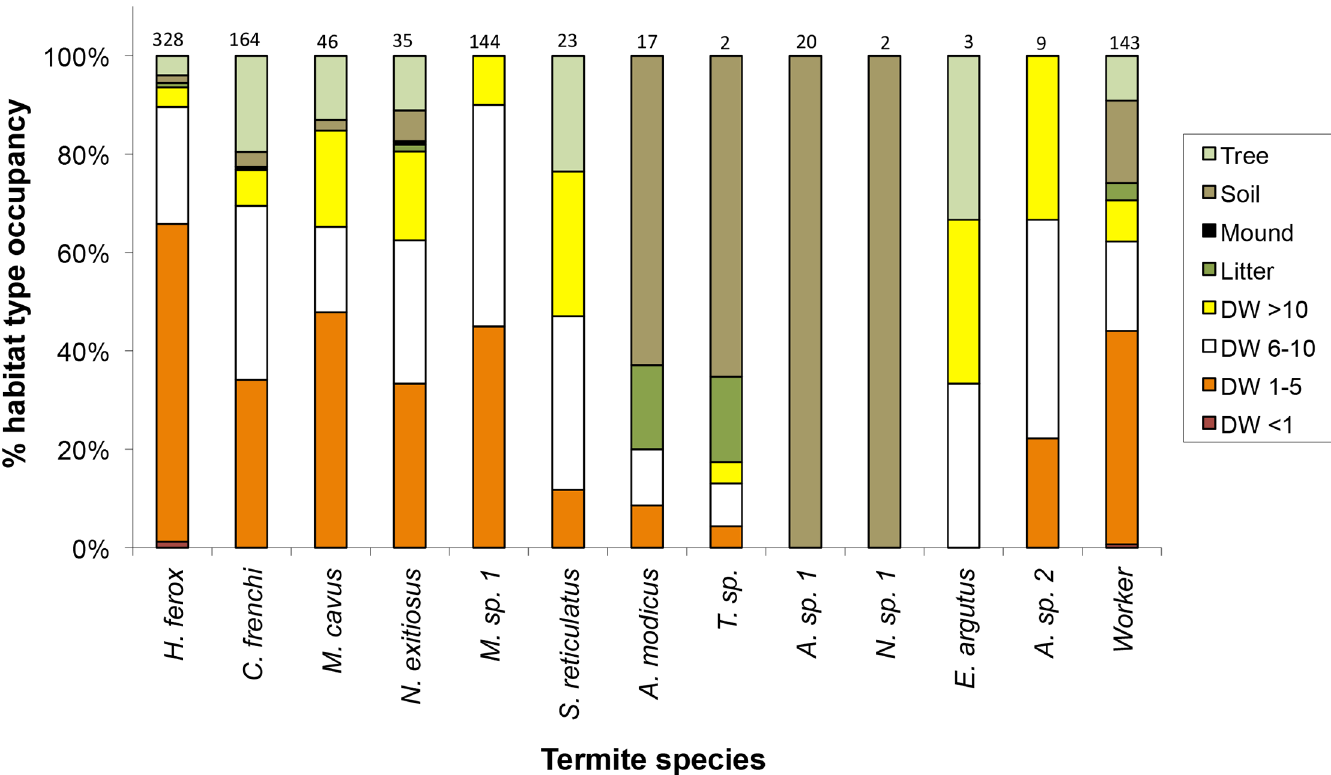
Fig 1. Habitat components in which each termite species was found. Shown as the percentage of records (total records at top of bars). DW < 1 = dead wood less than 1 cm in diameter, DW 6 – 10 = dead wood 6 – 10 cm and DW > 10 = dead wood greater than 10 cm diameter (n = 936 records from 140 transect